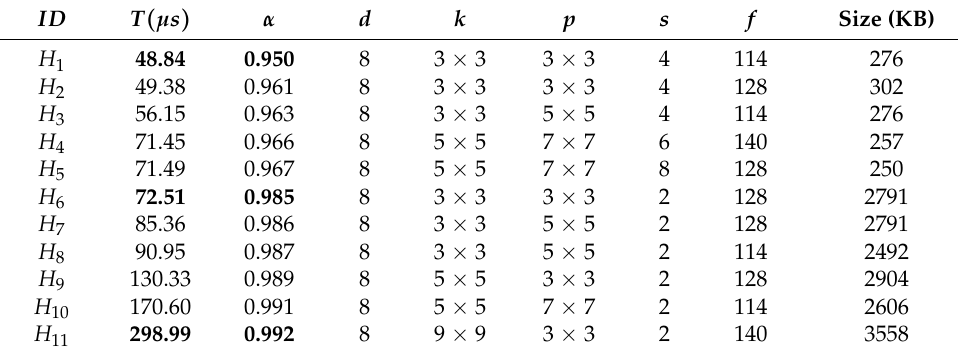
Table 5. Pareto and δδδ -Pareto optimal CNNs for MNIST where the example user requirements are: